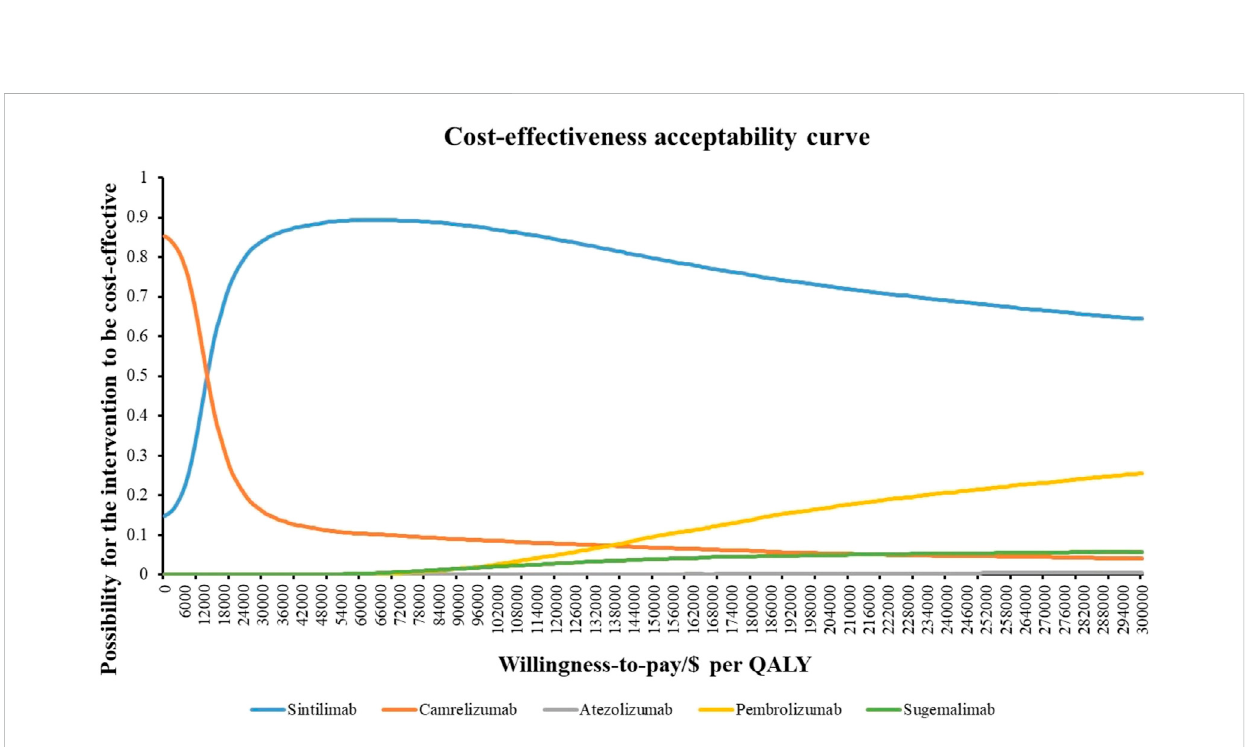
FIGURE 4 Cost-effectiveness acceptability curves of base-case probablistic sensitivity